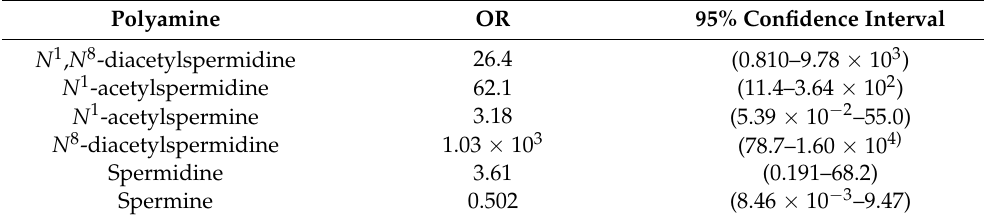
Table 2. Odds ratios (ORs) for salivary polyamines between patients with pancreatic diseases or gallbladder cancer and healthy